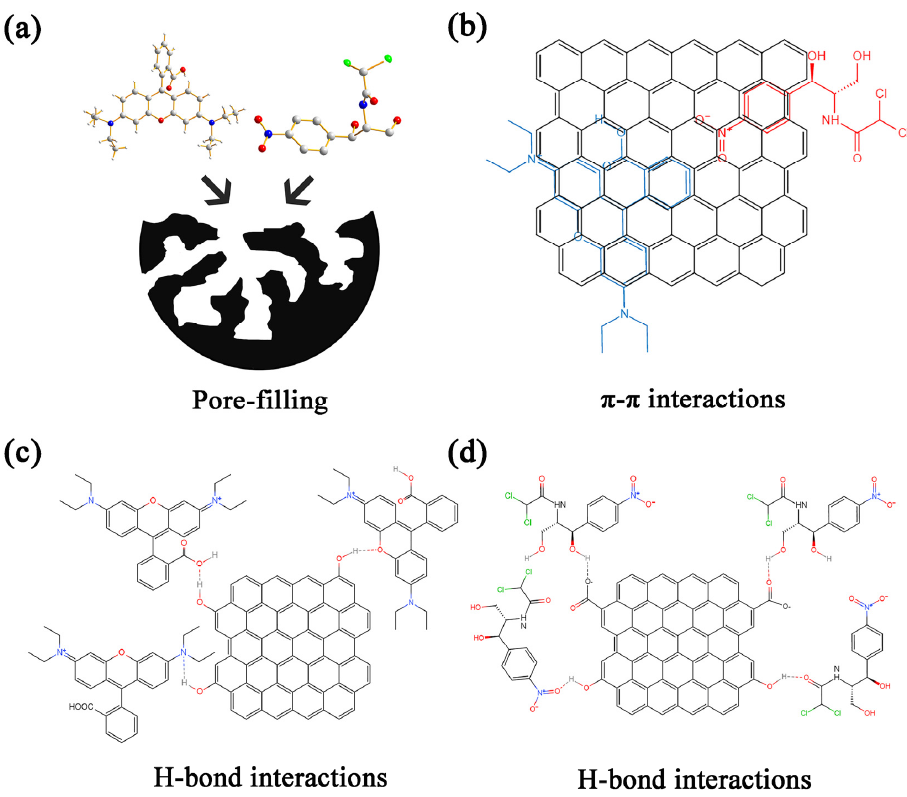
Figure 7. Adsorption mechanism of RhB and CAP on PCAC: ( a ) pore-filling, ( b ) π - π interactions, and ( c , d ) H-bond interactions.